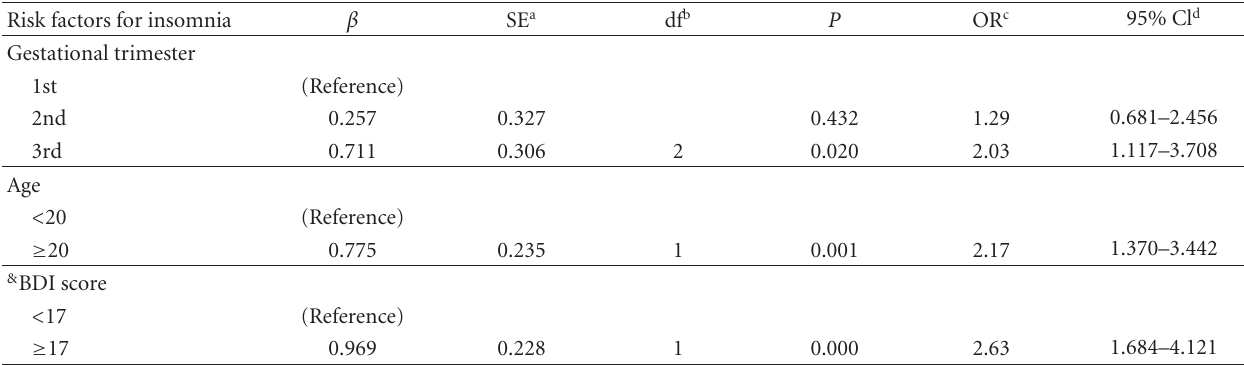
Table 4: Advanced analysis of the risk factors associated with insomnia in pregnant women ∗